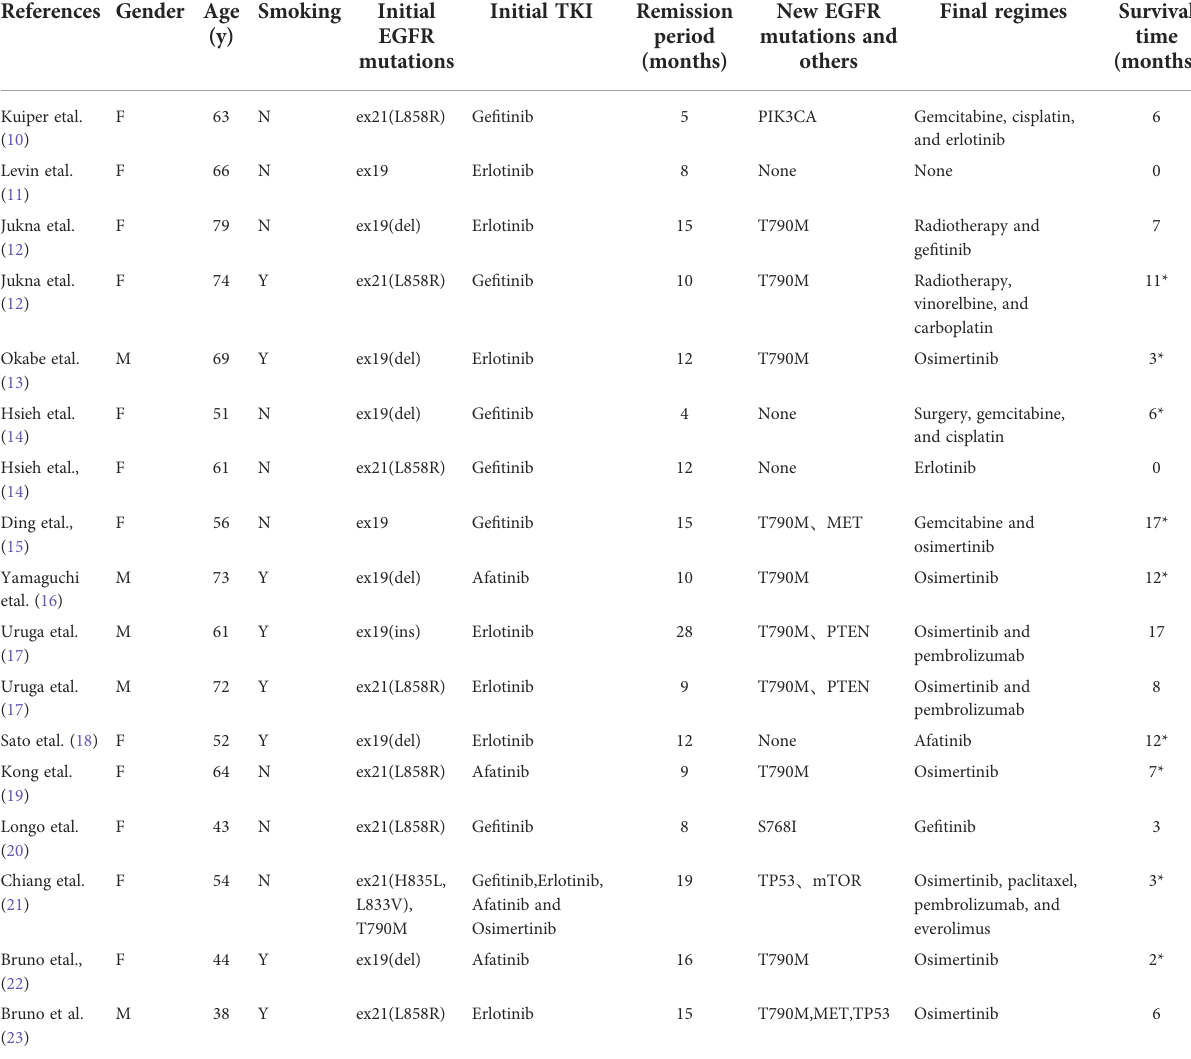
TABLE 1 Clinical characteristics of cases that converted from lung adenocarcinoma to squamous cell